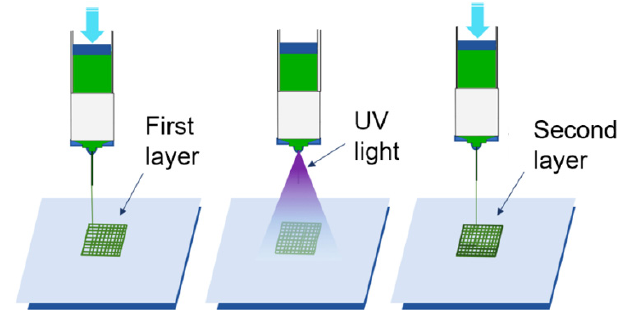
Figure 5. Illustration of layer-by-layer photo-crosslinking using UV light.